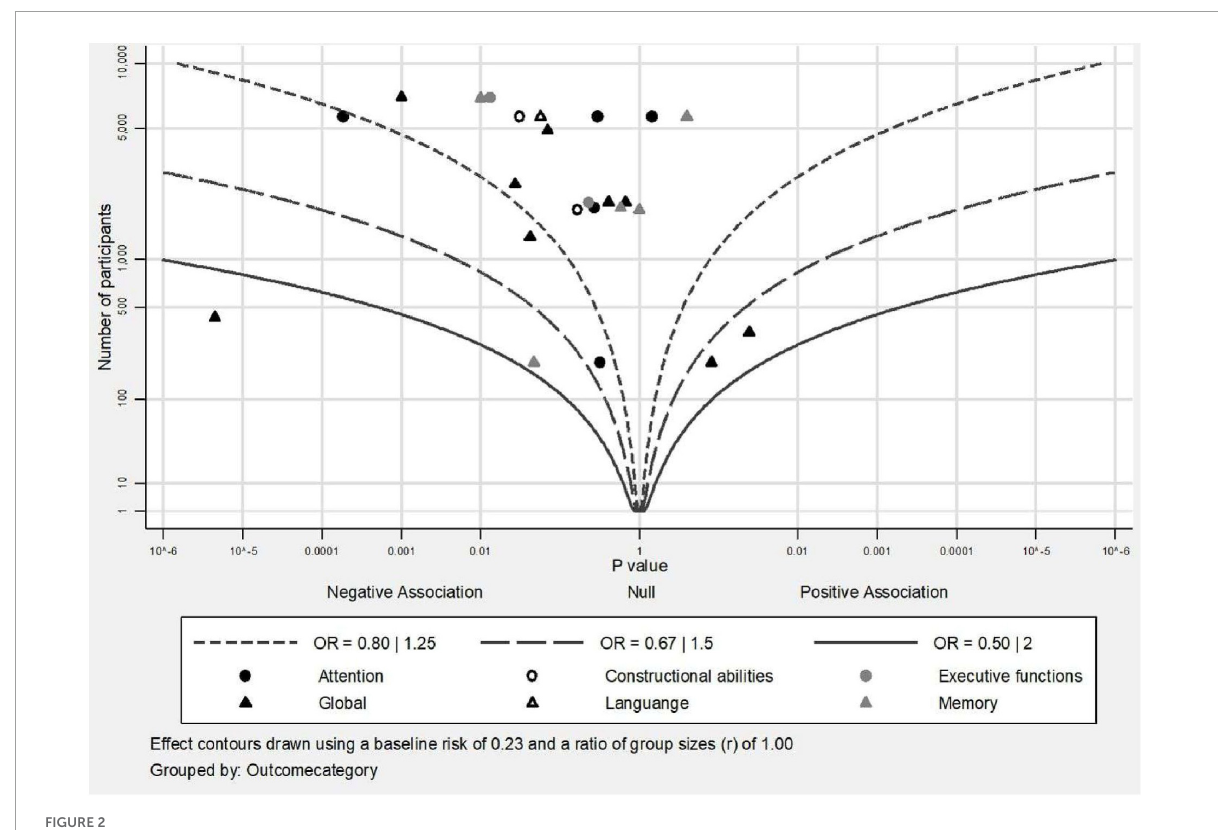
FIGURE2 Albatross plot of studies that investigated the association of MetS with categorical outcomes of